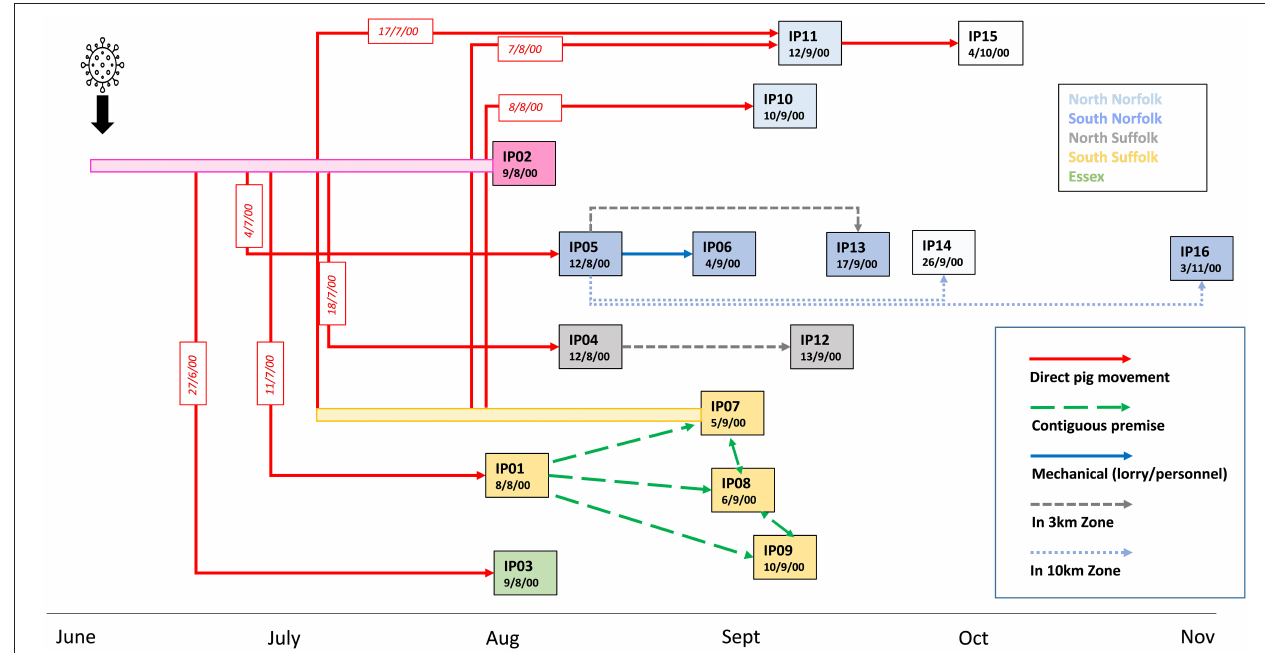
FIGURE 1 | Epidemiological links and timeline of the outbreak of CSF in the UK in 2000. Dates indicate the time of confirmation of CSF disease on the 16 premises (IP01-IP16) detected as infected during the 2000 outbreak. Premises were assigned IP numbers in the order of disease confirmation. Rectangle colors indicate the location of the premises within 5 geographical areas of the East Anglia region. Premises for which samples were not available are indicated by non-coloured rectangles. The most likely routes of transmission identified by epidemiological investigations are indicated by arrows. Dates of known direct movements of animals are indicated in red boxes. Bars before IP02 and IP07 indicate a potentially infectious period before disease confirmation on these premises from which direct animal movements